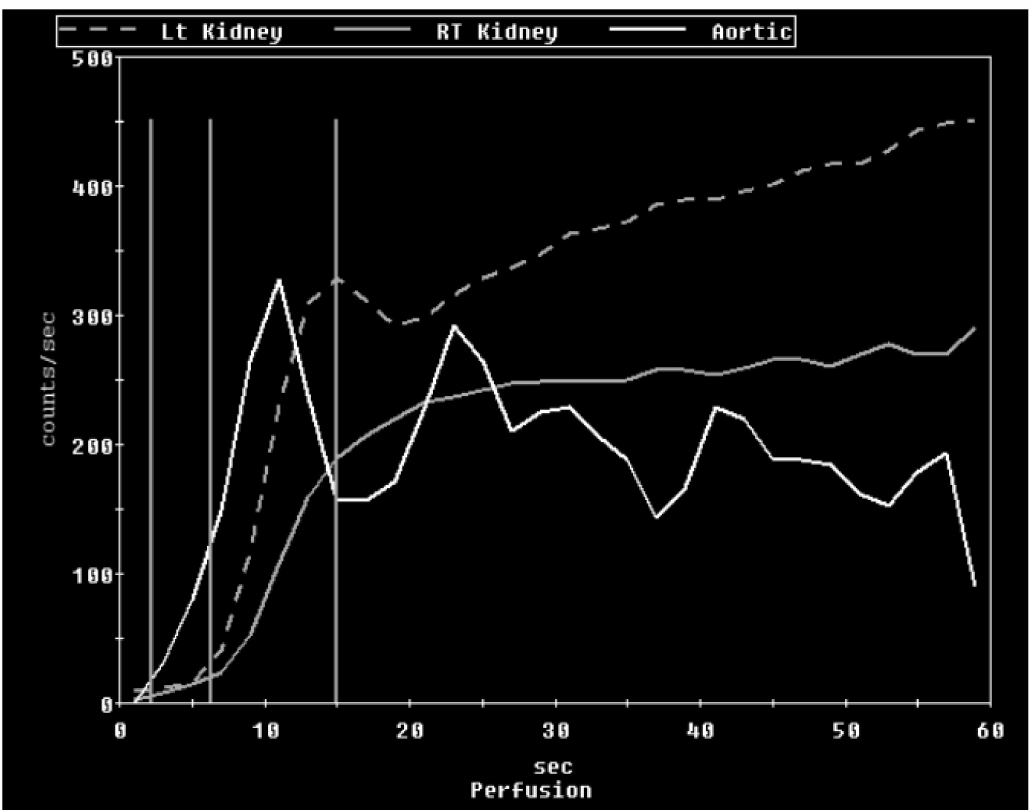
Figure 1. MAG-3 diuretic renal scan showing the time–activity curves in the perfusion phase. The right kidney had a slightly delayed uptake of MAG-3 with a reduced flow. The x-axis is labelled as radiotracer activity in counts / sec, and the y-axis is labelled as time in seconds following the infusion of the radiotracer.